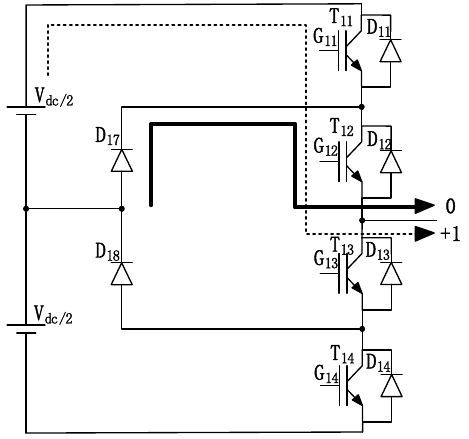
Figure 5. D3 type ( α = +1, M ≈ 0).